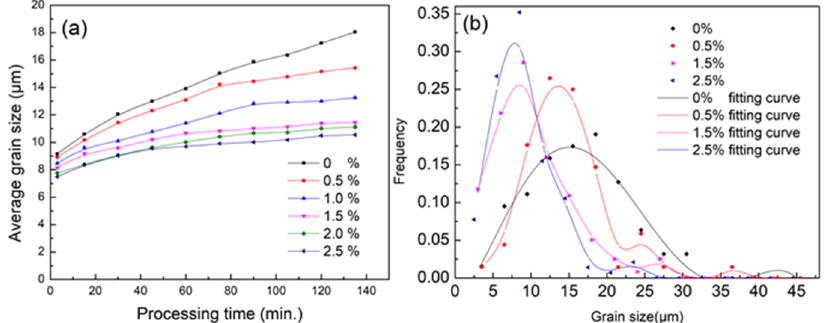
Figure 5. ( a ) The average grain size evolution at 573 K with second phase particles of different contents; and ( b ) the distribution of grain size annealing at 60 min.